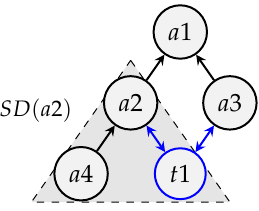
Figure 11. Routing graph G